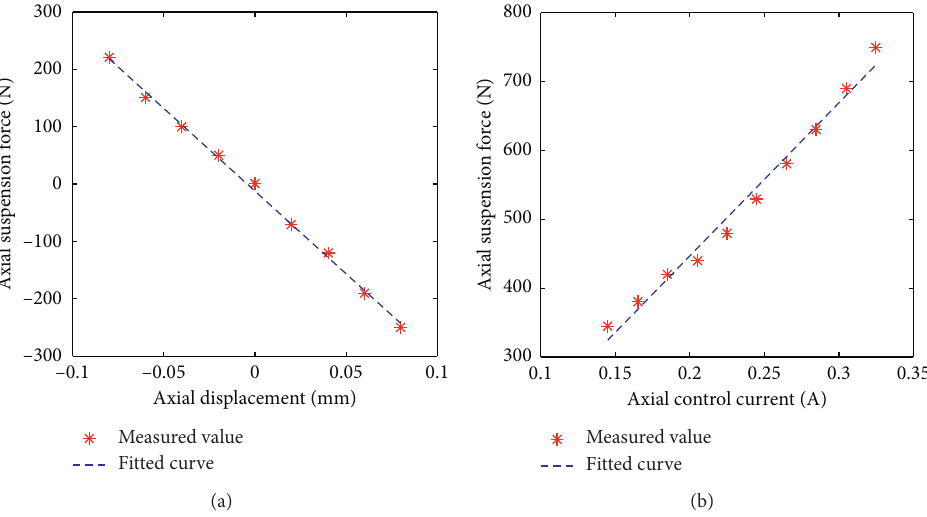
Figure 5: (a) Axial suspension force versus control displacement. (b) Axial suspension force versus control